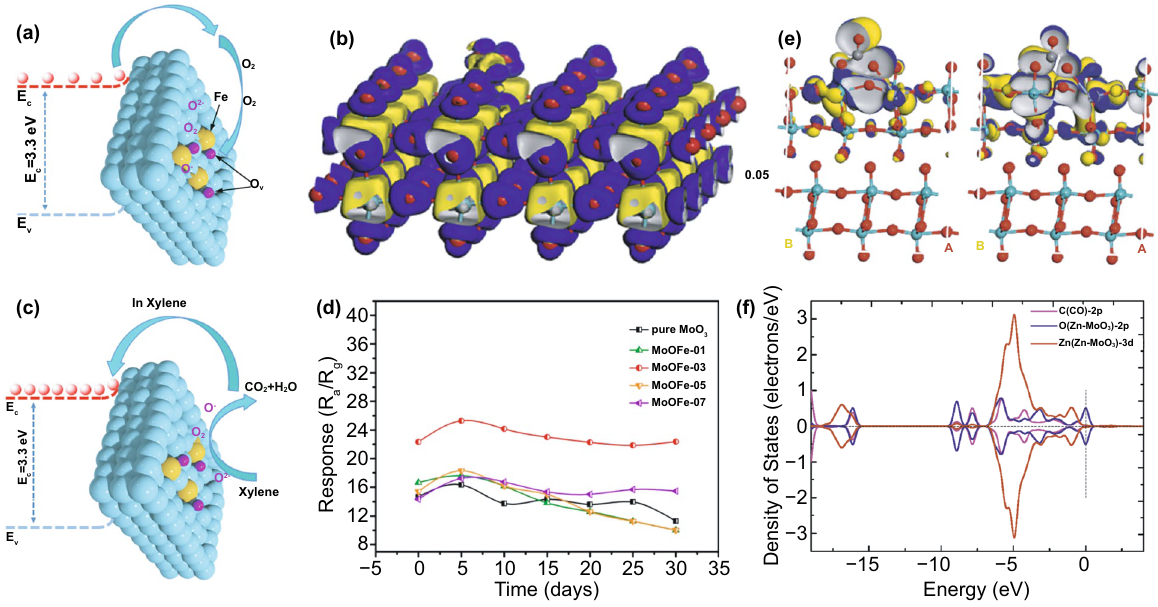
Fig. 6 Schematic diagram of a Fe-doped MoO 3 sensor and b its electronic density difference isosurfaces when exposed to oxygen molecules. c Schematic diagram and d long-term stability of Fe-doped MoO 3 sensor when exposed to xylene. ( a, c, d ) are reprinted with permission from Ref. [120]. Copyright 2020, Elsevier B.V. b is reprinted from Ref. [121]. Copyright 2020, Elsevier B.V. e HOMO (right) and LUMO (left) and f PDOS of CO-adsorbed Zn–MoO 3 (010) adsorption system. Reproduced from Ref. [122] with permission. Copyright 2020, Elsevier